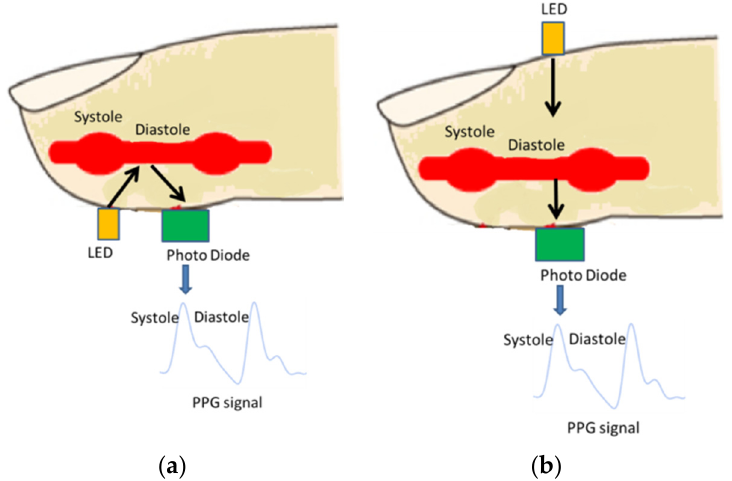
Figure 1. Schematic illustration of the photoplethysmography. The LED illuminates the skin and the nonabsorbed light will be detected by the photo diode. ( a ) For the reflected method, the LED and photo diode are on the same side. ( b ) For the transmitted method, the LED and photo diode are on the opposite side.